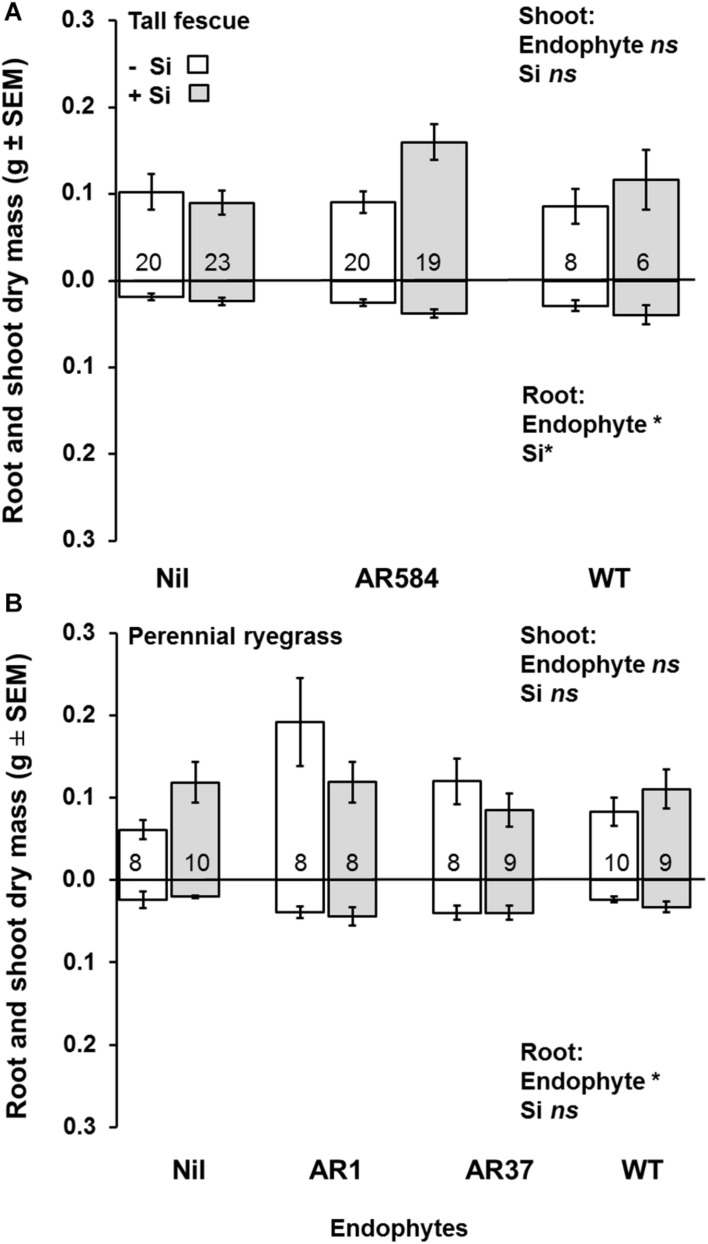
Variation in shoot (top) and root (bottom) dry mass for (A) tall fescue and (B) perennial ryegrass plants without endophytes (Nil) or colonized with different Epichloë endophyte strains growing hydroponically in the absence (−Si) or presence (+Si) of silicon (Si). Mean values ± standard error shown with N indicated within each bar. N is unbalanced due to removal of plants with wrong endophyte status (see %Supplementary Table S1). Models with significant main effects and/or interactions (P < 0.05) noted with *, ns = non-significant effects (see Table 1 for full analysis).